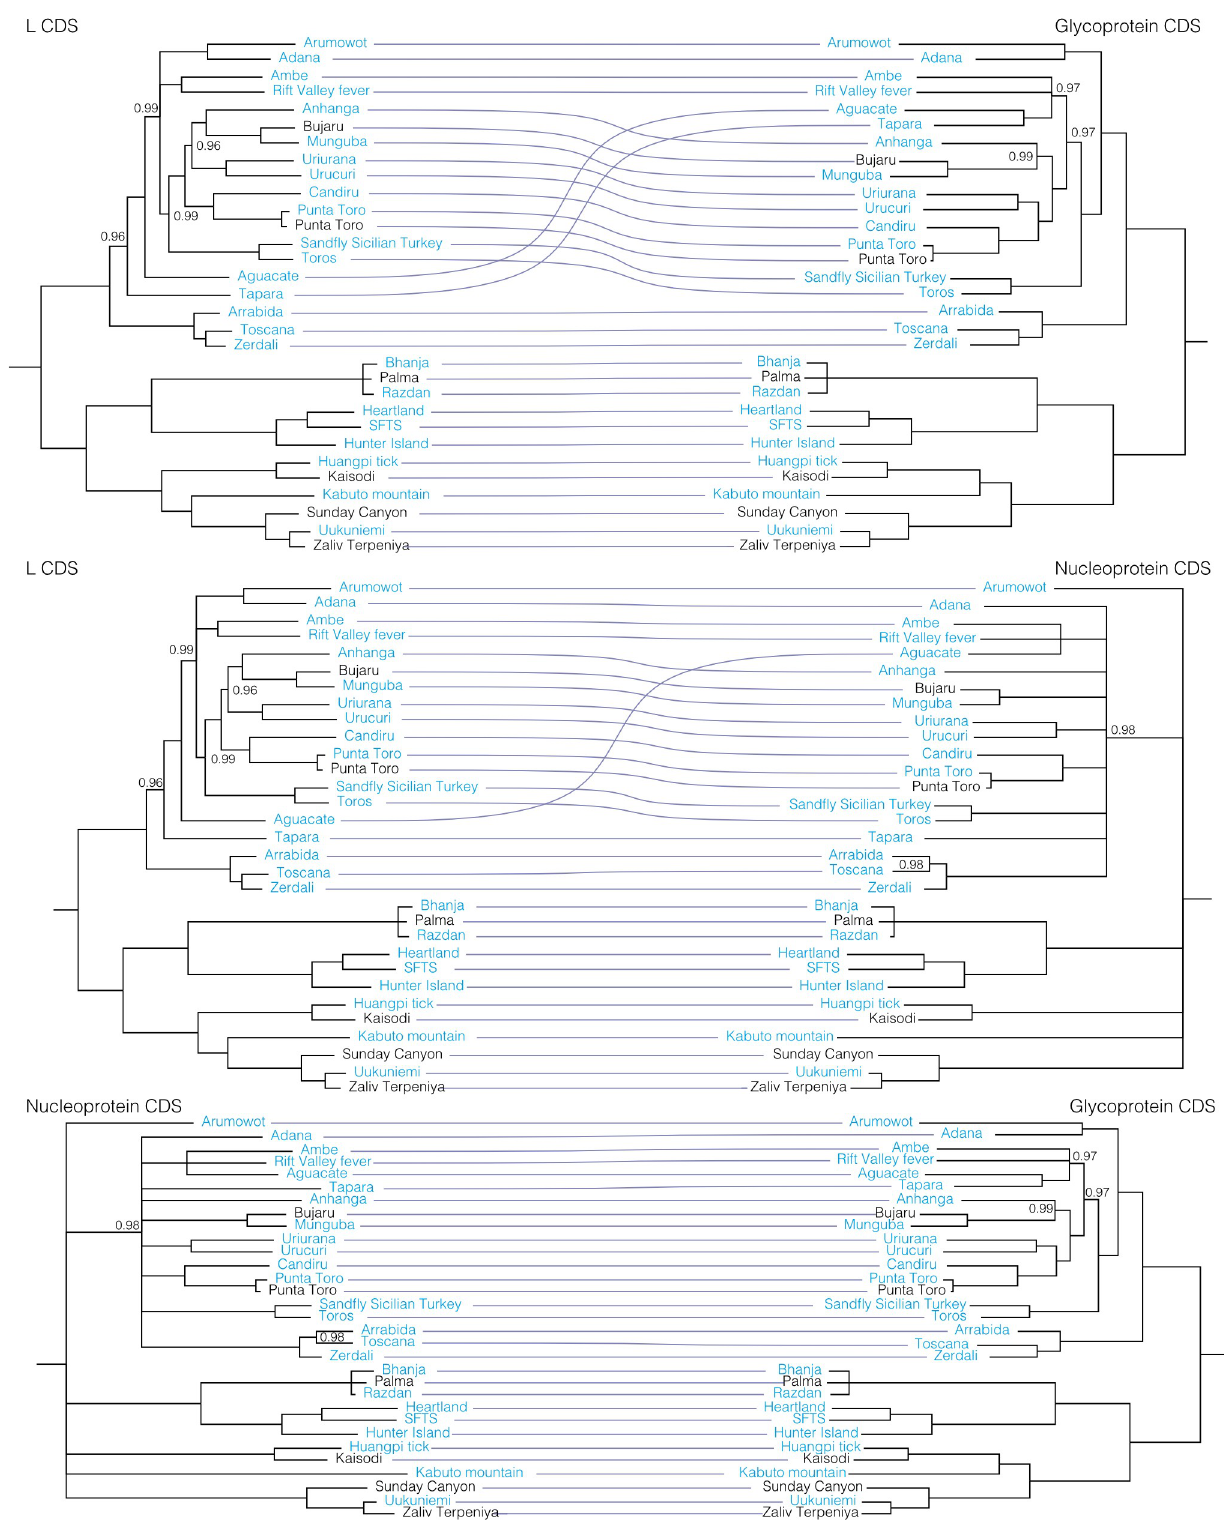
Fig 11. Co-phylogenies of Phenuiviridae L, M, and S segment trees. Branches with support values < 0.95 were converted to polytomies. All other branch support values were 1 unless indicated. Trees were rooted with outgroups as in Fig 6.